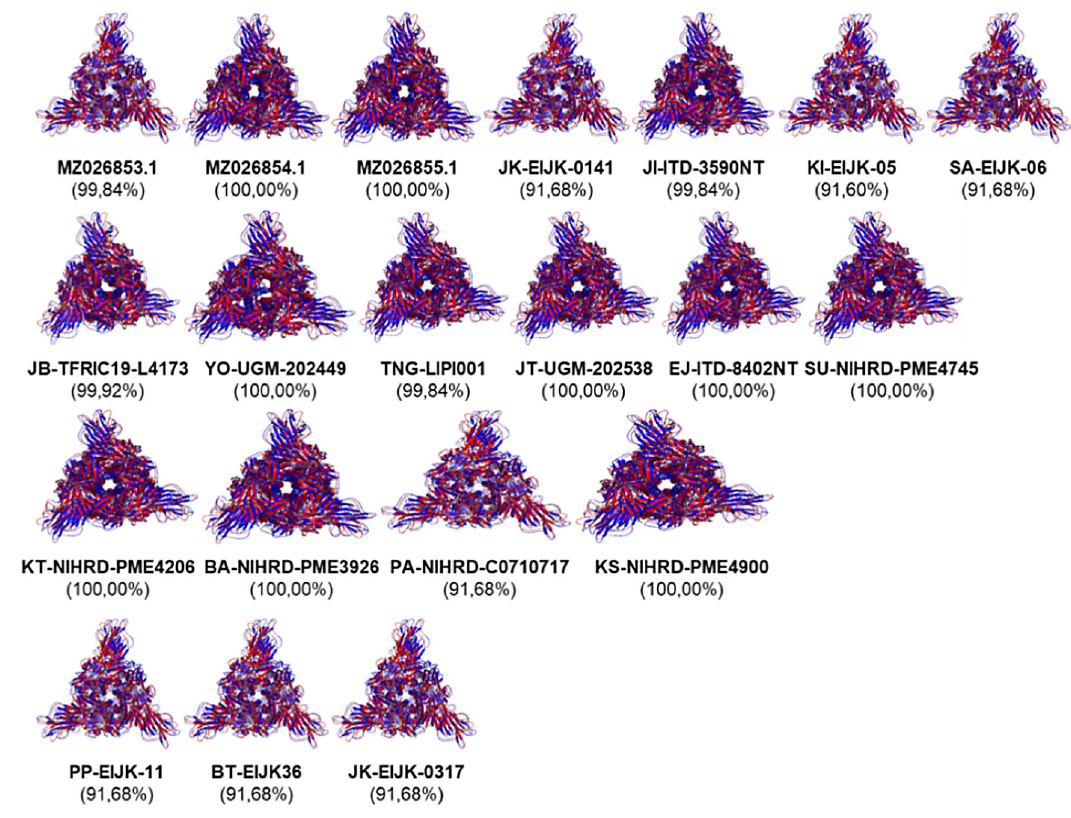
Figure 1. 3D structure comparison of spike glycoprotein SARS-CoV-2 from Indonesian isolates (blue) with references (red). The structures are displayed in cartoons and colored based on the isolates via PyMol